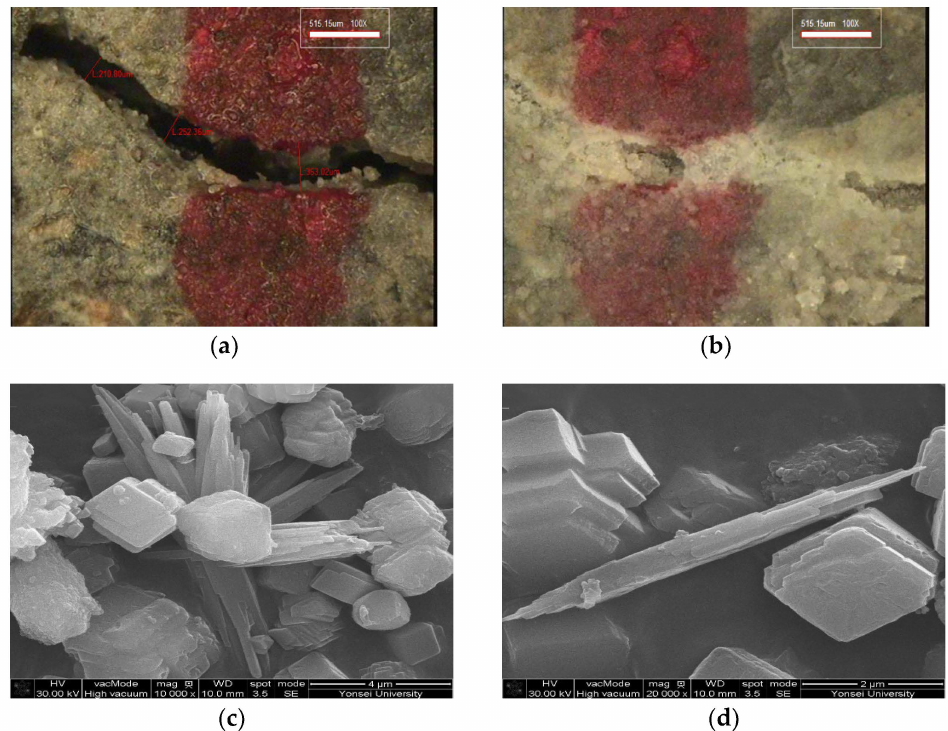
Figure 10. Crack monitoring results: ( a ) initial crack; ( b ) healed (healing period of 28 days); ( c ) SEM ( × 10,000); ( d ) SEM ( ×